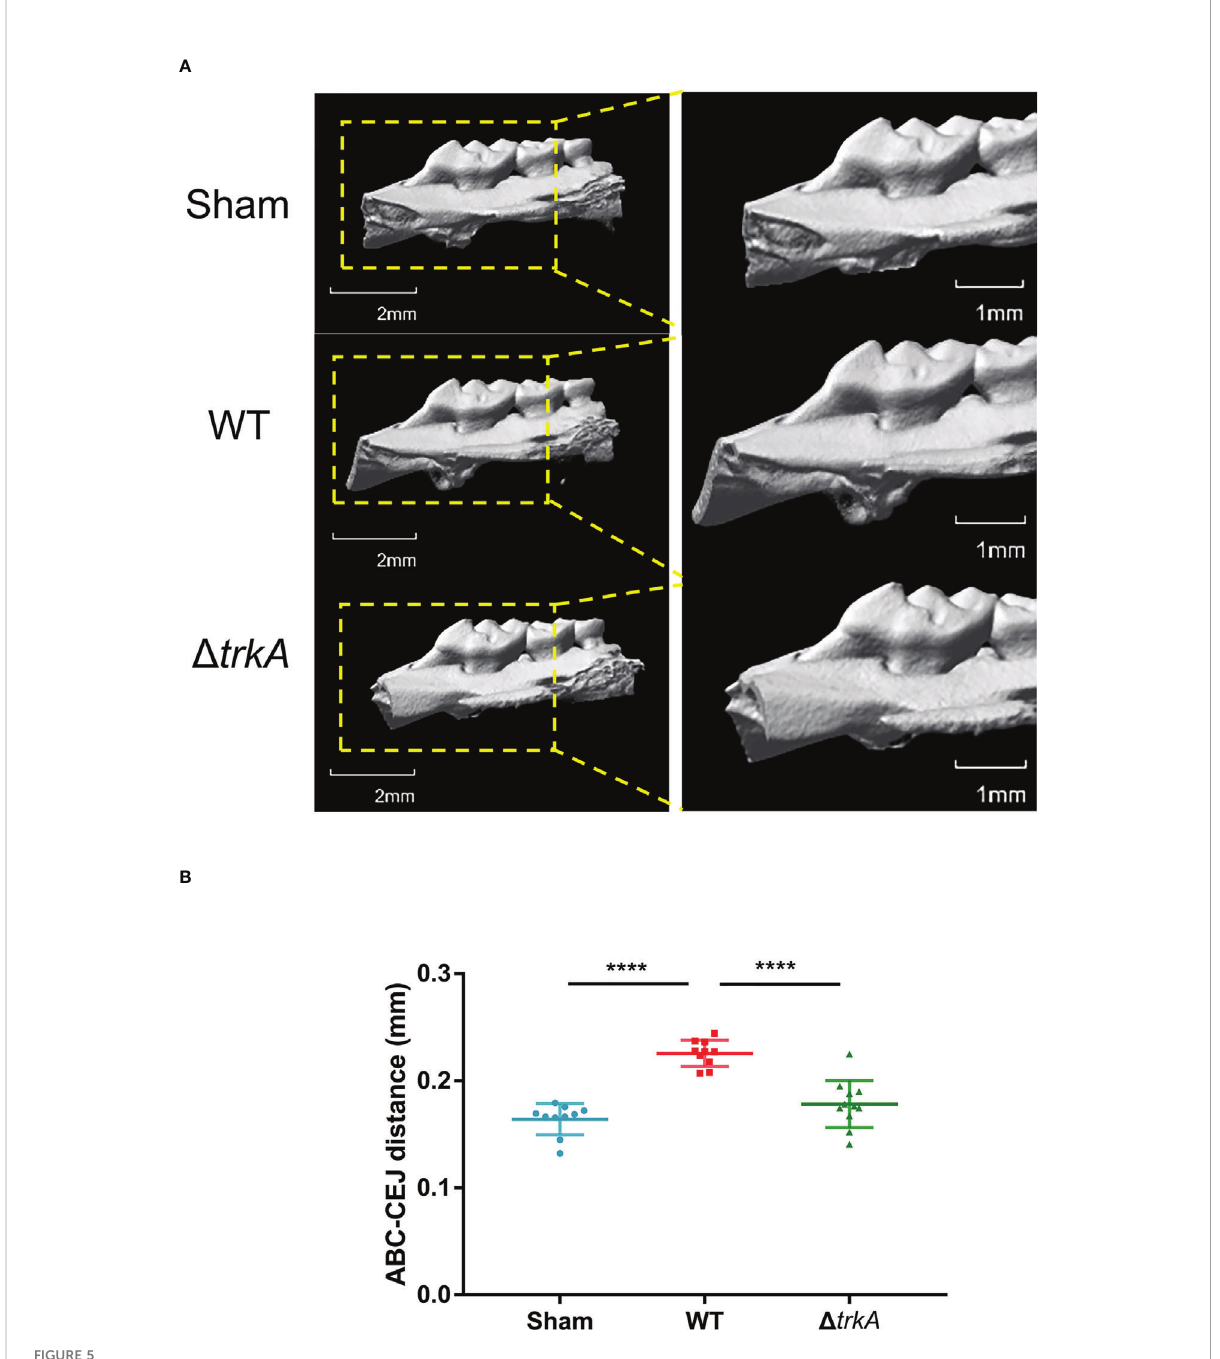
FIGURE 5 trkA is required for the virulence of Porphyromonas gingivalis in vivo . Micro-CT analysis of alveolar bone loss in mice following infection with P. gingivalis wild-type and D trkA strains. The group treated with CMC (sham) worked as a control. (A) Three-dimensional micro-CT reconstruction of the alveolar bone and (B) analysis of bone resorption. All data of the distance between ABC and CEJ in 14 sites of the fi rst, second, and third molars were measured and presented as mean ± SD. ABC, alveolar bone crest; CEJ, cementoenamel junction. N = 10 or 11, **** p <